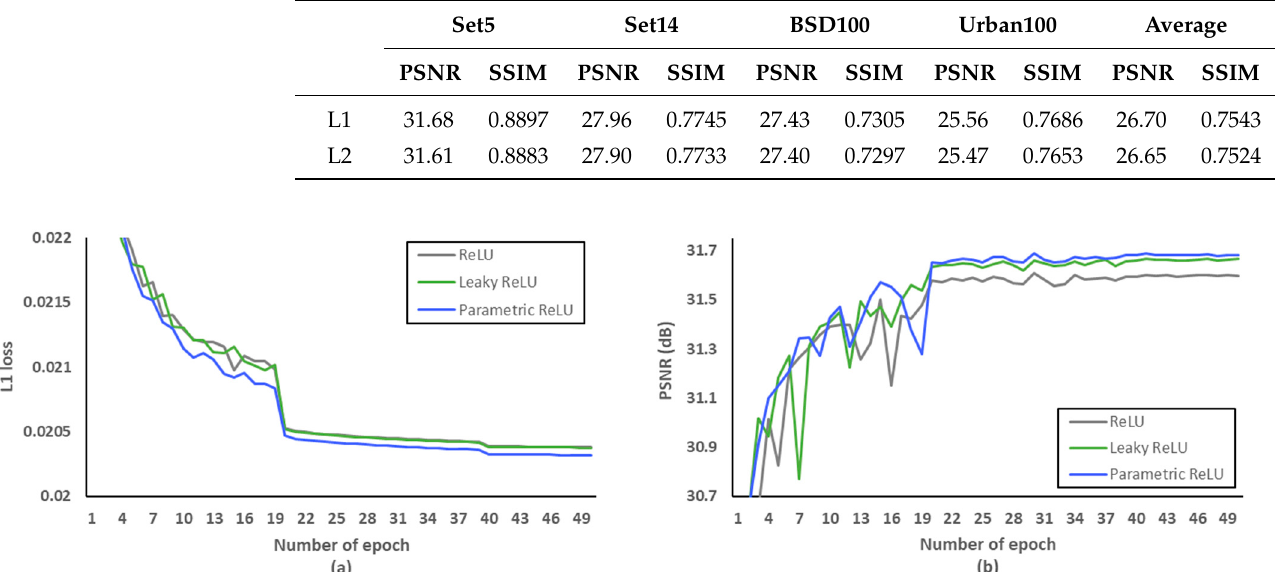
Figure 9. Verification of activation functions. ( a ) L1 loss per epoch. ( b ) PSNR per epoch.